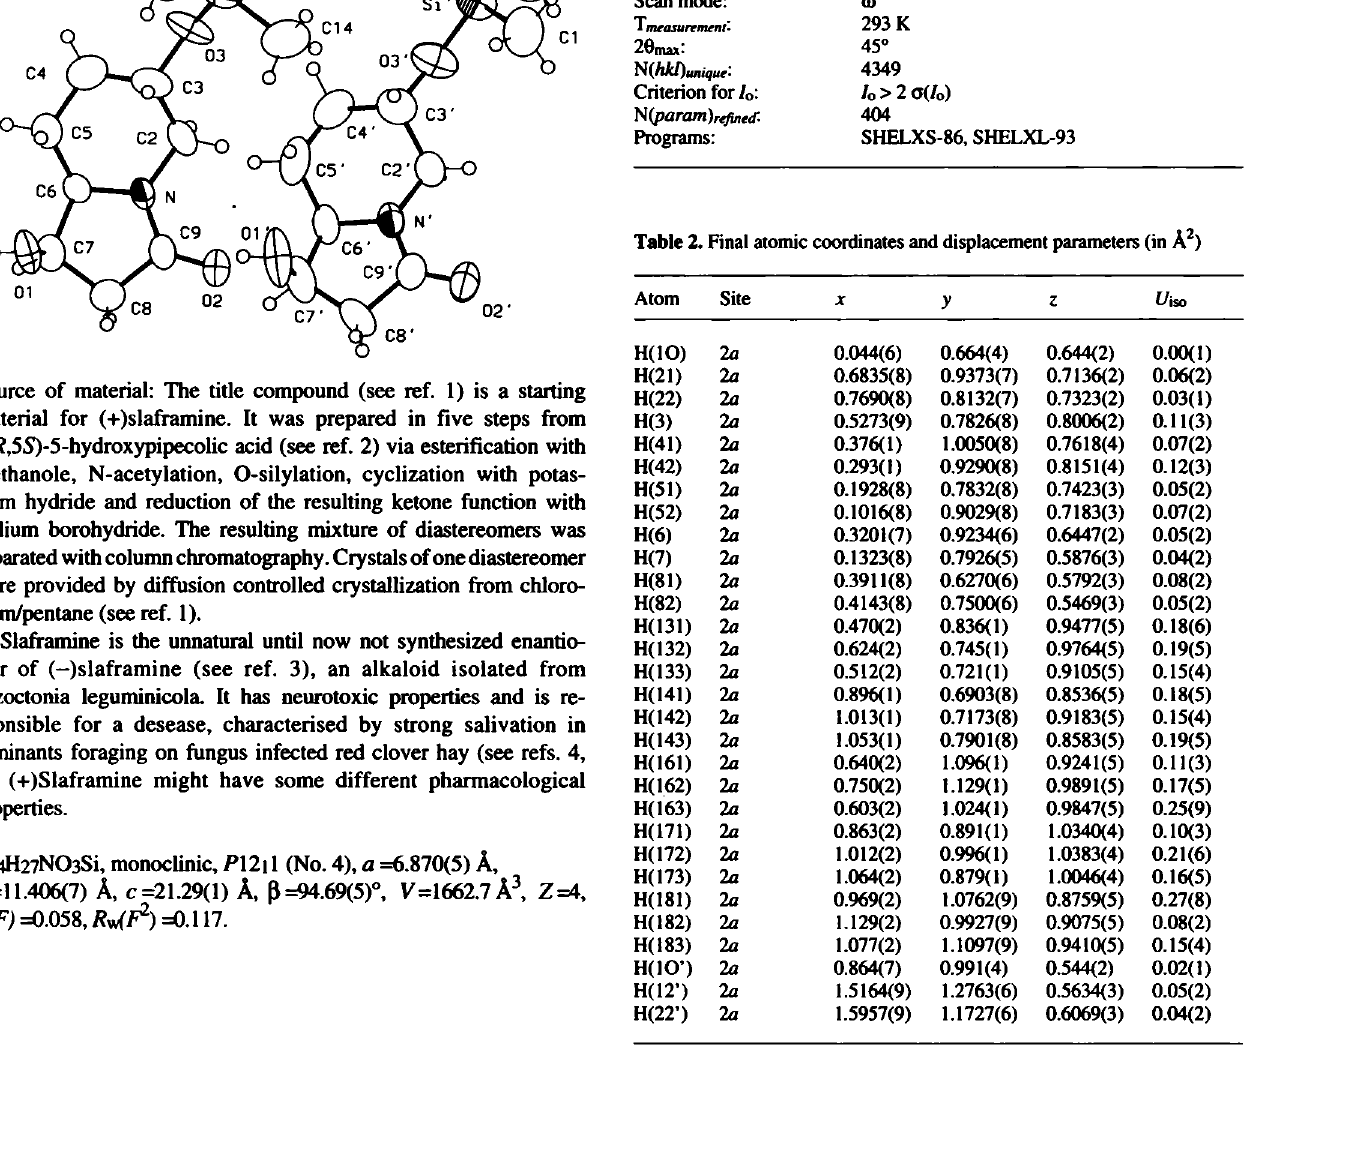
Table 1. Parameters used for the X-ray data collection Crystal: